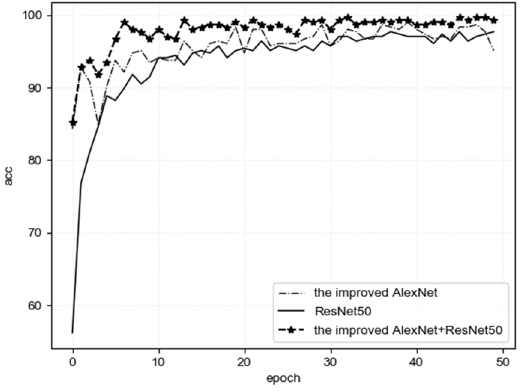
Figure 14. Accuracy comparison curves of different algorithms.